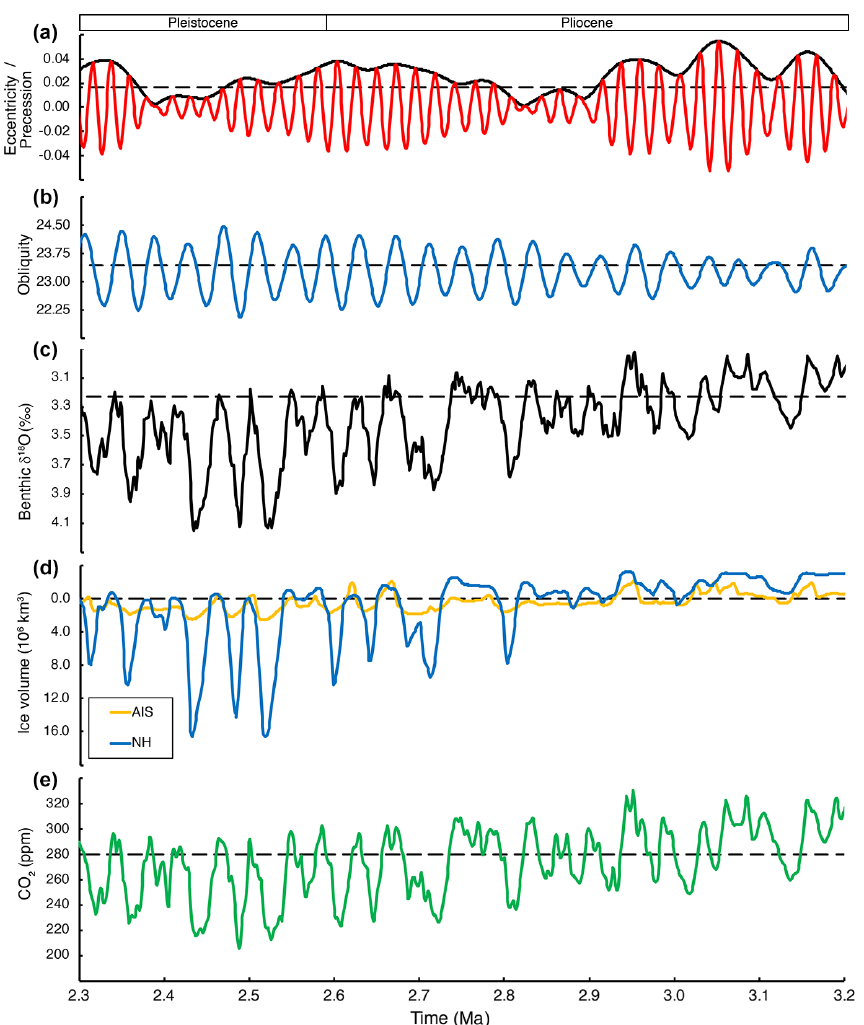
Figure 2. Climatic forcing records used as input for CLIMBER-2 over the time studies from 3.2 to 2.3Ma. (a) Eccentricity in black, climatic precession in red, and (b) obliquity in blue (Laskar et al., 2004). (c) The benthic LR04 δ 18 O record (Lisiecki and Raymo, 2005) used for reference. (d) Global ice volume reconstruction (in 10 6 km 3 on land) for the Antarctic Ice Sheet (AIS) in orange and the total NH in blue from de Boer et al. (2014). The y axis is reversed for (c) and (d) , with cold climate below. (e) Atmospheric CO 2 concentrations (in parts per million; ppm) generated using the methodology described in van de Wal et al.